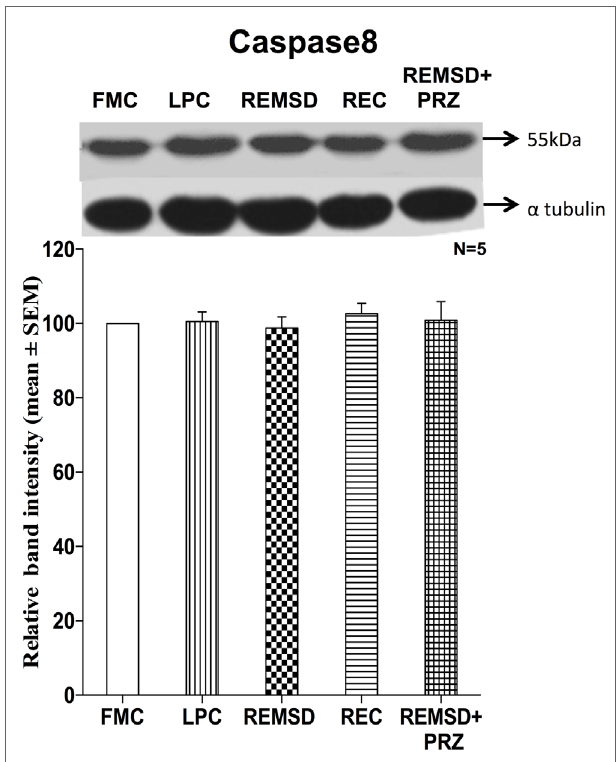
FigUre 8 | caspase8 expression in the brain homogenate of rats maintained under different conditions . Upper panel shows a representative Western blot of caspase8. Histogram in the lower panel shows percent changes in the mean ( ± SEM) band densities of the blots as compared to FMC taken as 100% in five sets of experiments. Abbreviations are as in the text.